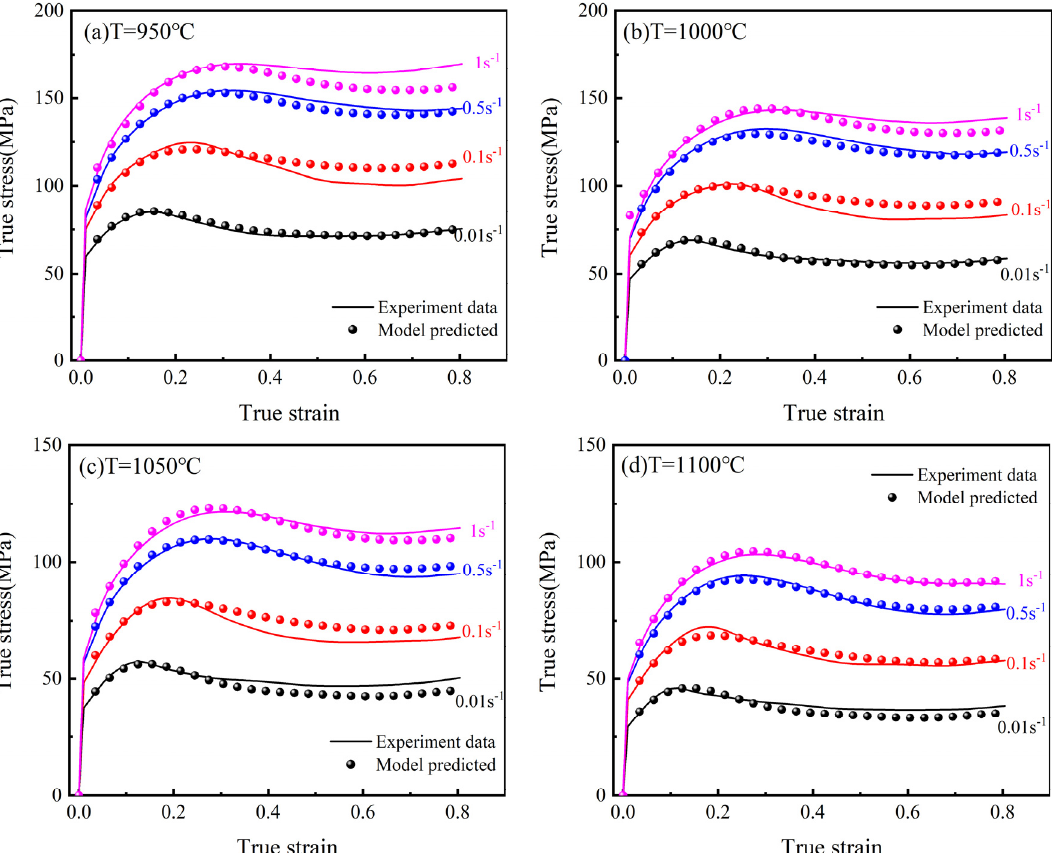
Figure 11. Arrhenius modeling results from the experimental data at different temperatures and strain rates. ( a ) T = 950 °C; ( b ) T = 1000 °C; ( c ) T = 1050 °C; ( d ) T = 1100 °C.